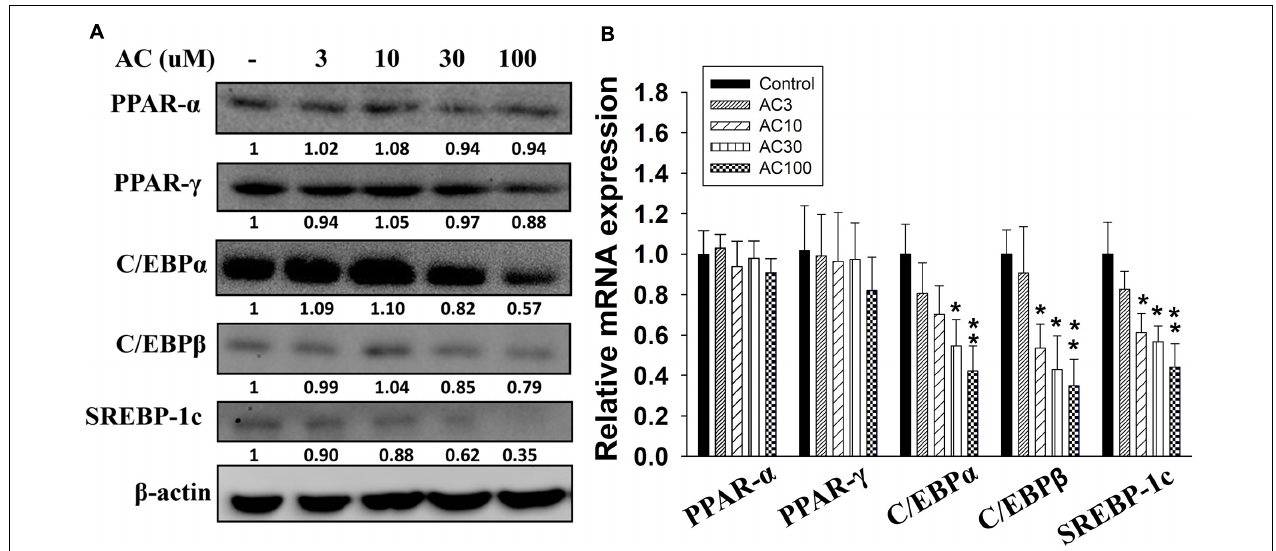
FIGURE 2 | The effect of acacetin (AC) (3–100 µ M) on the expression of transcription factors involved in adipogenesis in 3T3-L1 cells. (A) Differentiated 3T3-L1 cells were treated with acacetin for 24 h. The protein expression of PPAR- α , PPAR- γ , C/EBP α , C/EBP β , and SREBP-1c was determined using Western blot